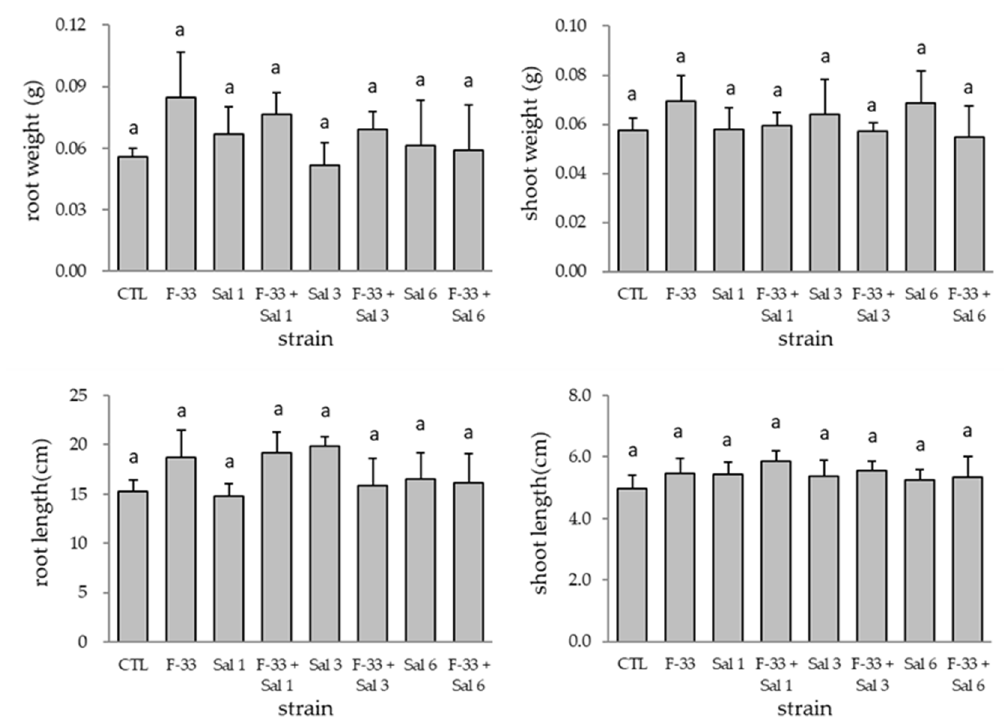
Figure 3. The effects of co-inoculation of Bacillus sp. F-33 with the other endophytic strains, Klebsiella sp. Sal 1, Enterobacter sp. Sal 3, and Herbaspirillum sp. Sal 6, on the growth of the tomato plant. The tomato plant was cultivated using sterilized vermiculite, and the parameters were measured at 14 days after seed inoculation. CTL represents the control samples inoculated with autoclaved cultures. The bars represent the standard deviation (n = 6), and different letters indicate significant differences at p < 0.05 by Tukey’s